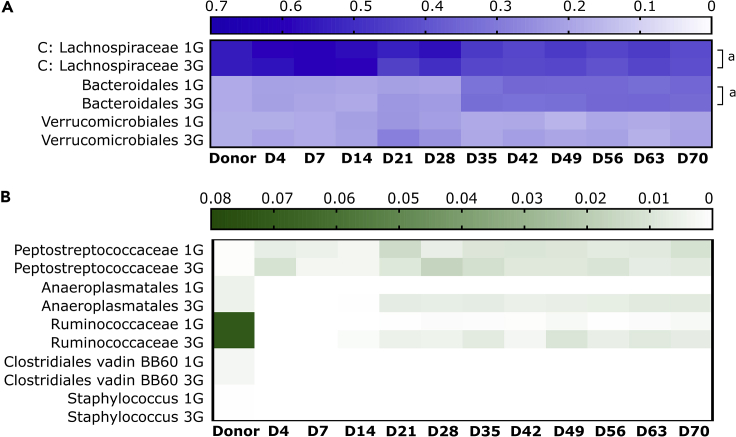
Relative abundance of donor taxa in recipient mice receiving the antibiotic-disrupted microbiotaHeatmap of relative abundance of taxa at the order level in recipient that received one (1G) or three gavages (3G) of the antibiotic-disrupted microbiota were plotted at the order level. Bacterial taxa in the Clostridiales order were plotted at the family level, while order levels comprising a single taxa were plotted according to the genus level. Bacterial taxa were plotted according to (A) high relative abundance (>0.1 relative abundance) and (B) low relative abundance taxa (<0.1 relative abundance). Significant differences between 1G and 3G groups during initial colonization (D4 to D21) or in at least two timepoints during D28 to D70 were indicated were determined based on a linear mixed-effects model (lmerTest) in R (denoted as a or b, respectively, p < 0.05). Color gradient of the heatmap were based on mean relative abundance values.